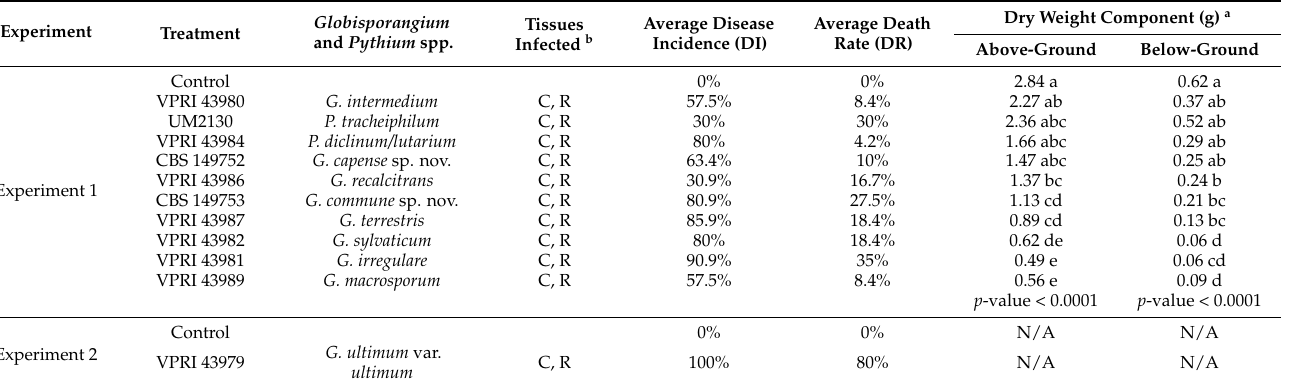
Table 3. Average disease incidence, death rate and dry weight of pyrethrum seedlings six weeks after inoculation with Pythium and Globisporangium species. In the same column, means of dry weight that do not share the same letter are significantly different by combination of General Linear Model and Tukey’s Pairwise Comparison test ( α =